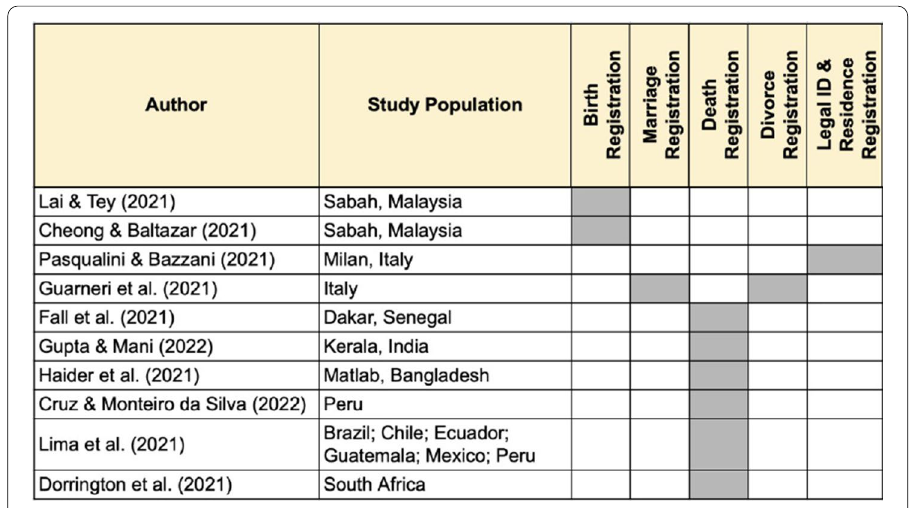
Fig. 2 Engagement of Genus thematic series papers with different components of civil registration and vital statistics systems and legal identity